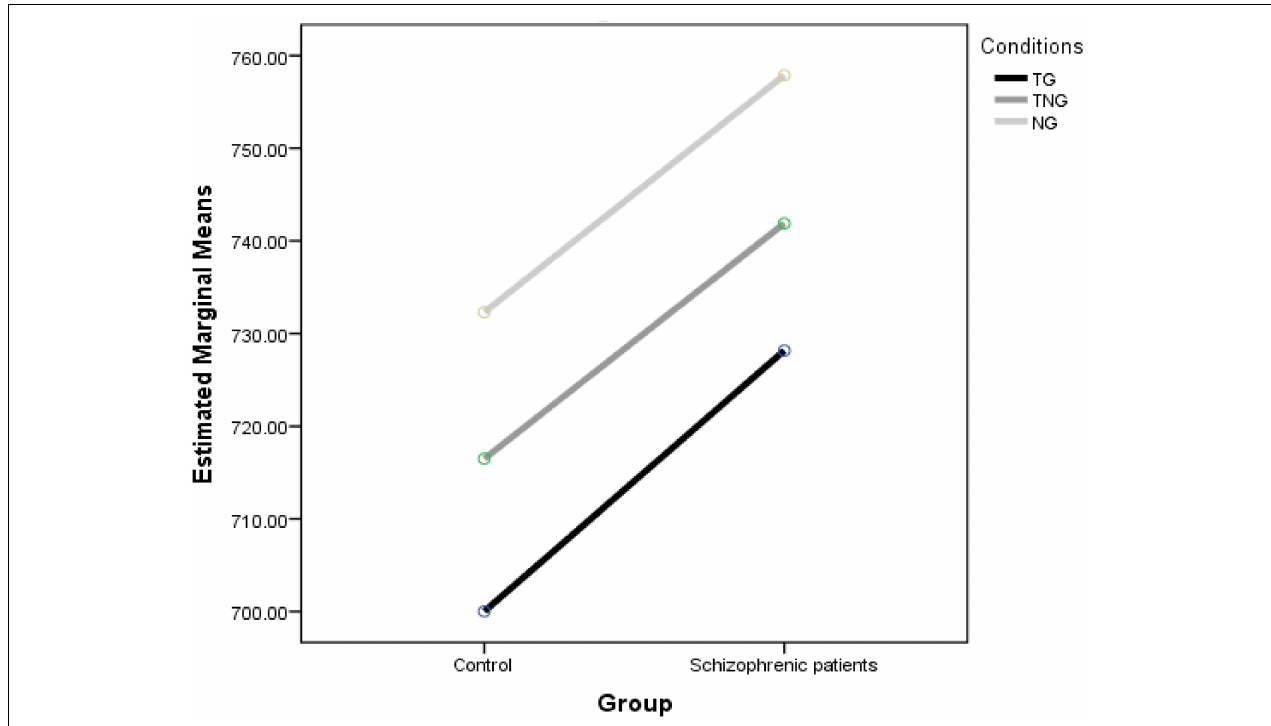
FIGURE 2 | Effect of preceding (NG) and simultaneous (TNG) distractors on number parity decisions compared to simple number decision task